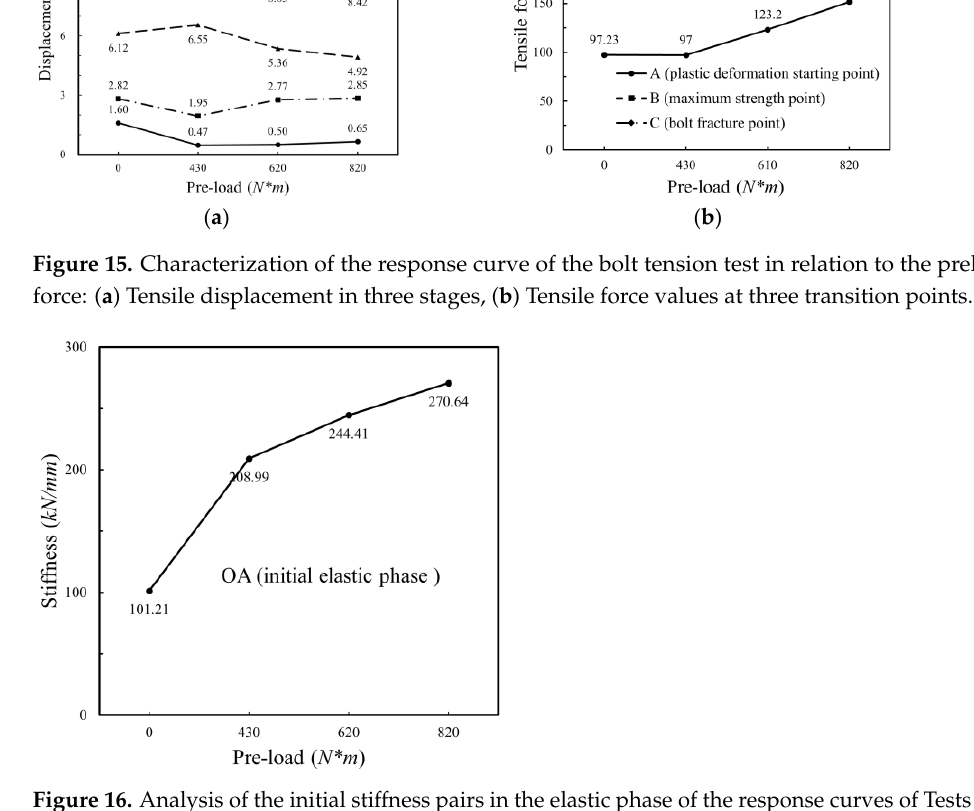
( d ) Figure 17. VCSB-induced failure deformation and fracture cross-section: ( a ) Test 1 (T P = 0 N ∙ m), ( b ) Test 2 (T P = 430 N ∙ m), ( c ) Test 3 (T P = 610 N ∙ m), ( d ) Test 4 (T P = 820 N ∙ m).